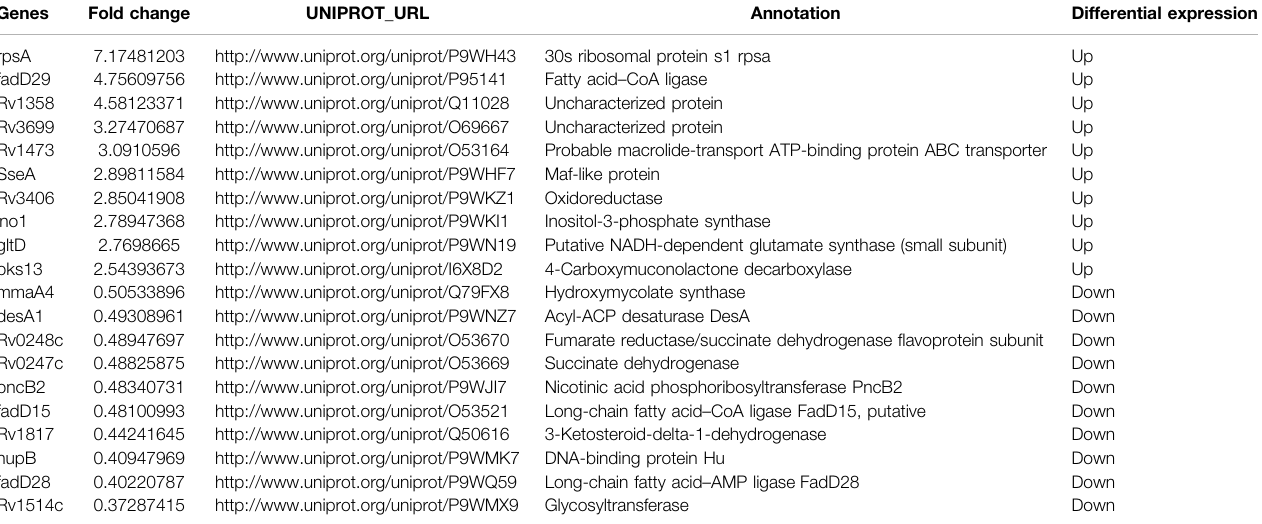
TABLE 4 | The top 10 differentially expressed proteins in BCG based on M.tb. Genes Fold